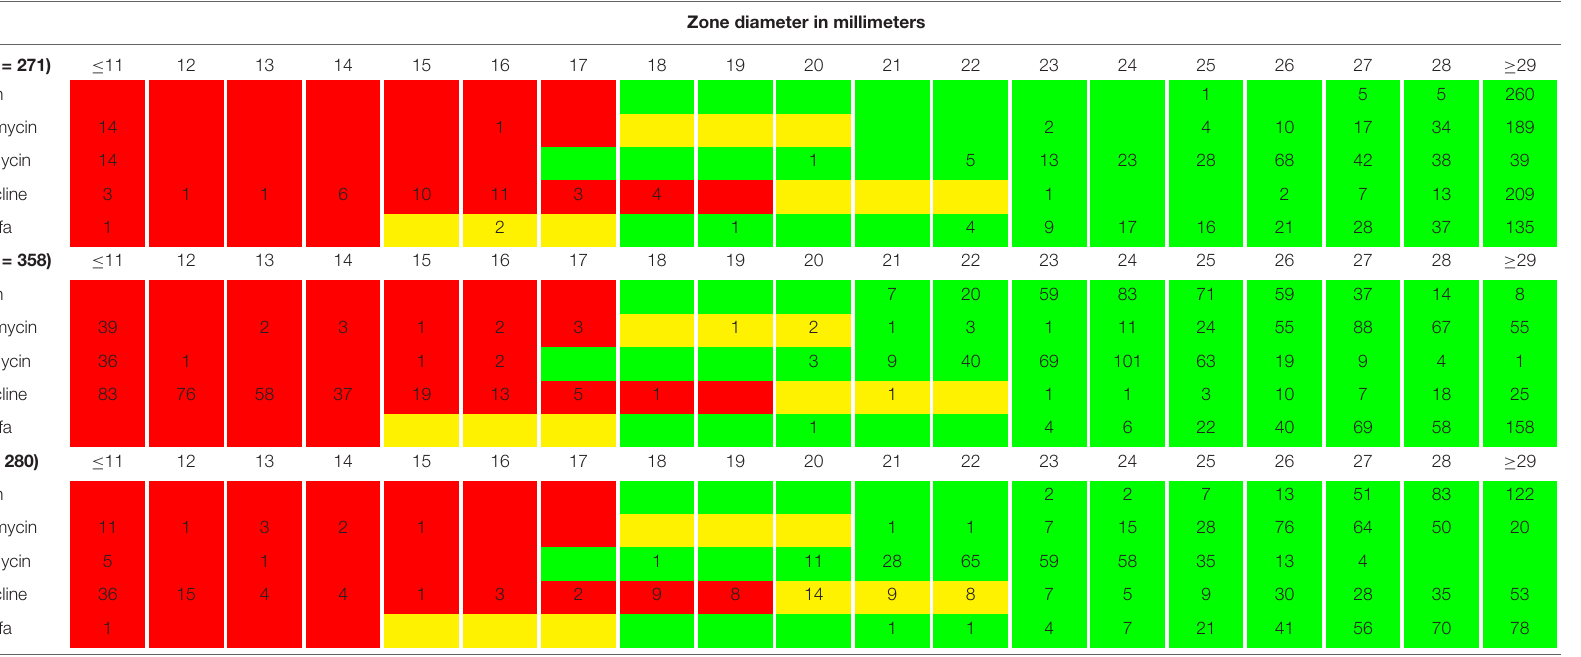
TABLE 1 | Distribution of antimicrobial resistance testing zone